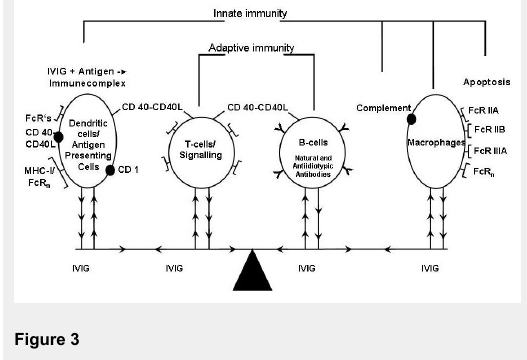
Synergistic (arrows) interactions after IVIG administration. From left to right hand side: – Immune complex formation, activation of dendritic cells and their Fc receptors; – Antiplatelet T- cell reactivity, suppression of T cells, cytokine release and increase of T regulatory cells; – Downregulation of B-cells and anti-idiotypic antibodies; – Blockade of Fc receptors by IVIG; Complement binding/clearing Apoptosis and Fas inhibition (modified from © Imbach P, Lazarus A, Kühne T. Intravenous immunoglobulins induce potentially synergistic immunomodulations in autoimmune disorders. Vox Sanguinis. 2010;98:385–94. Reprinted with kind permission).